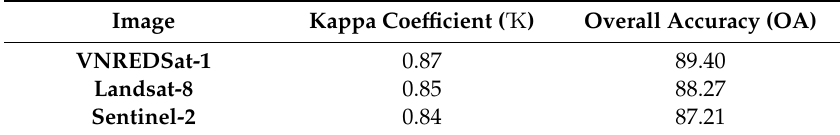
Table 7. The Kappa coe ffi cient and overall classification accuracy for images sourced from three di ff erent satellites.